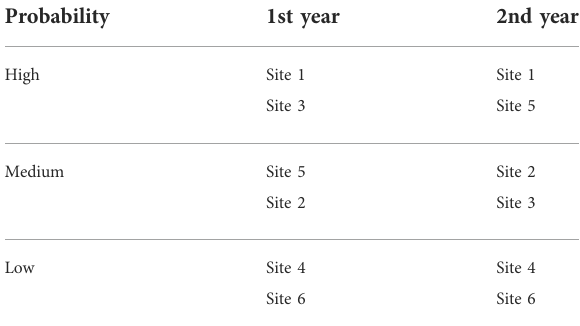
TABLE 2 The estimated probability class that the detected BTCs originate from